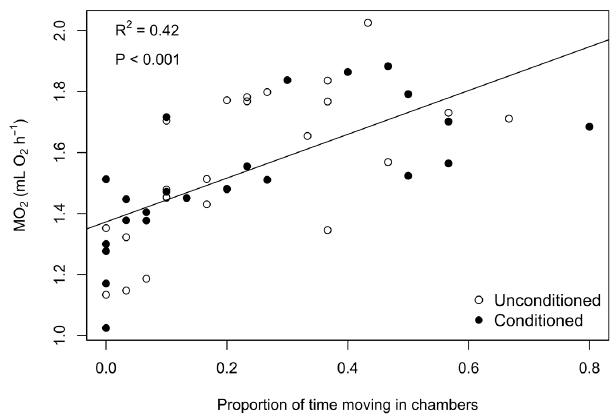
Figure 1. Linear relationship between routine metabolic rate and proportion of time moving in respirometer chambers. The added regression line shows the strong relationship between general activity (i.e., turning, rocking, or moving) and oxygen consumption during exposure trials.